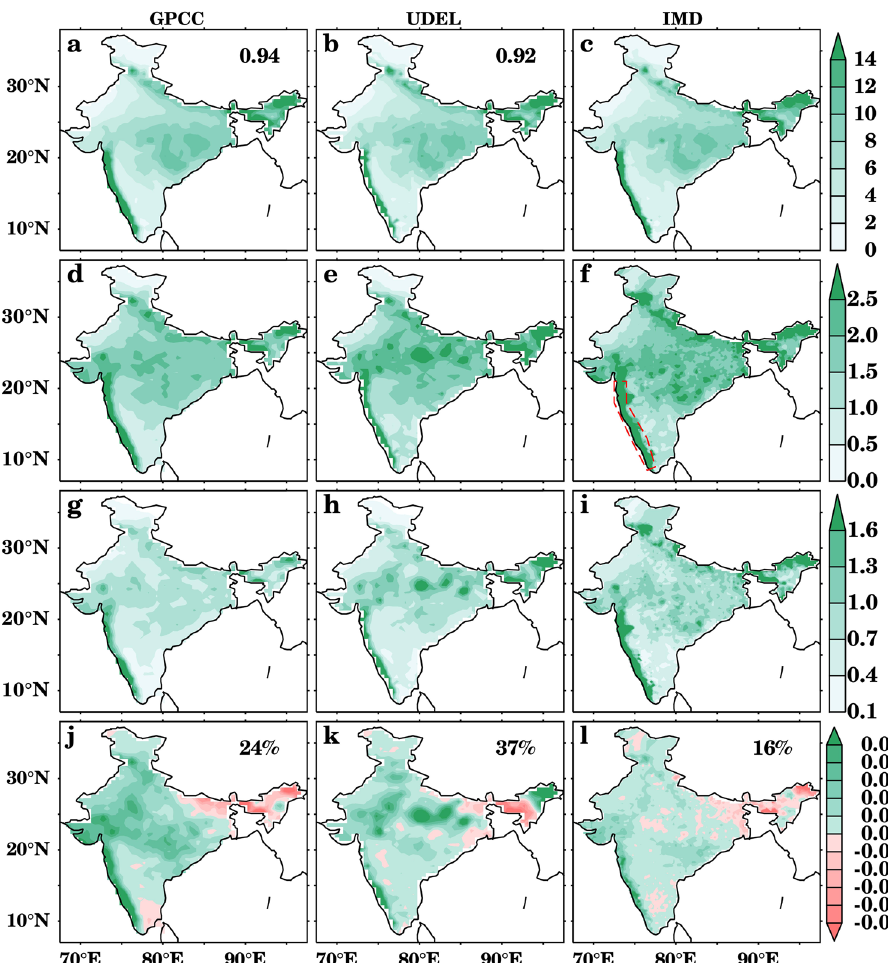
Fig. 1 Spatial distribution of mean and variability of summer monsoon rainfall over India. Spatial distribution of long-term mean summer monsoon rainfall (mm/day) from a GPCC, b UDEL, and c IMD. Numerical values in the right top corner in a and b showing pattern correlation with c IMD data. The standard deviation of summer monsoon rainfall (mm/day) from d GPCC, e UDEL, and f IMD and standard deviation of 9 – 30 years bandpass fi ltered summer monsoon rainfall (mm/day) from g GPCC, h UDEL, and i IMD. EOF leading fi rst mode of 9 – 30 years bandpass fi ltered rainfall anomaly over Indian landmass from j GPCC, k UDEL, and l IMD. The percentage of total variability explained by EOF1 is shown in the top right corner in j , k , and l . The selected area in f using dashed lines representing the domain considered for Western Ghats rainfall index